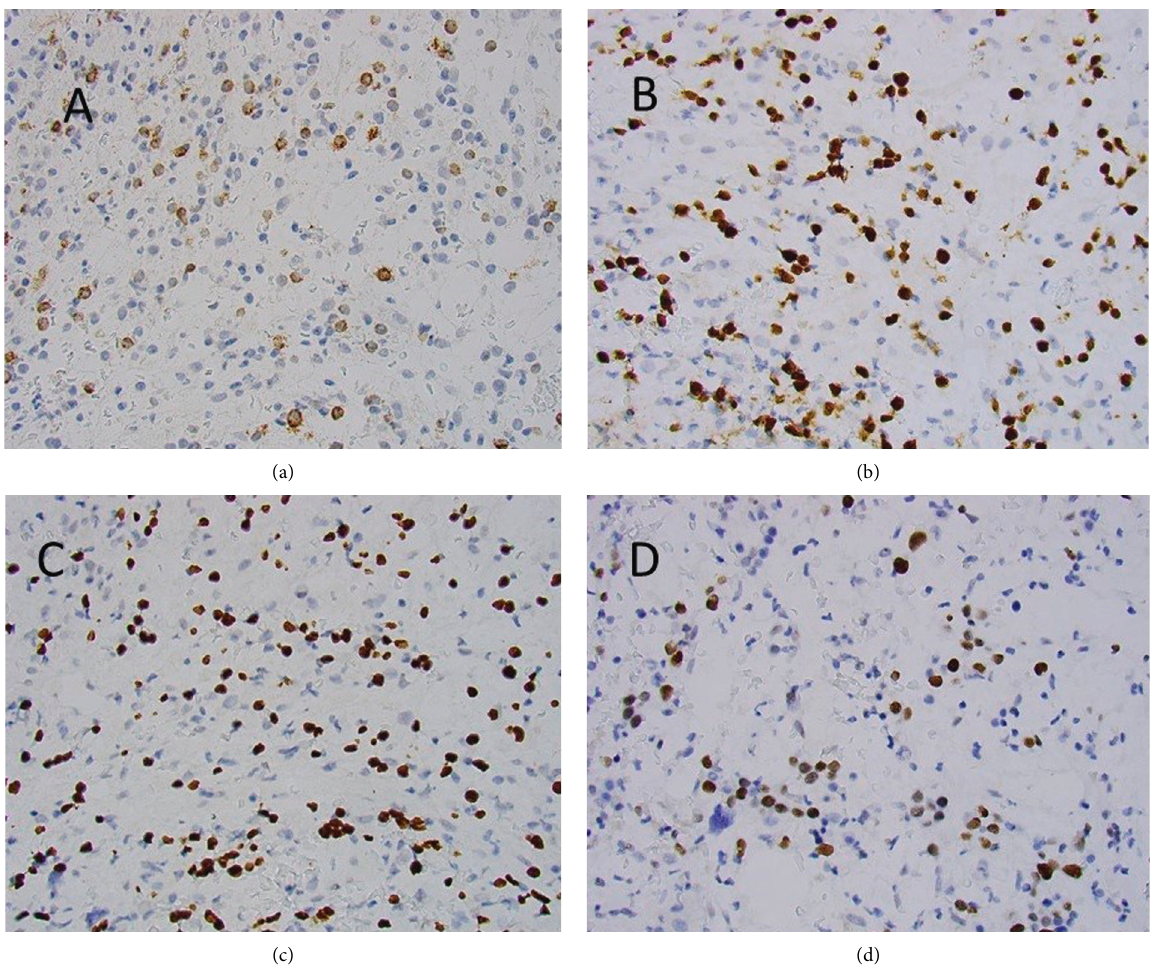
Figure 2: Immunohistochemistry-stained bone marrow biopsy sections showing: A-Positive CD34 staining in immature cells, B- Positive TdT staining in immature cells, C- Positive PAX-5 staining in immature cells, and D- Positive c-MYC staining in immature cells